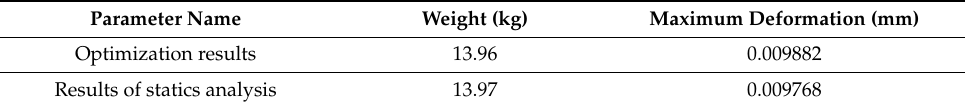
Table 5. Comparison between optimization results and mechanical verification results.